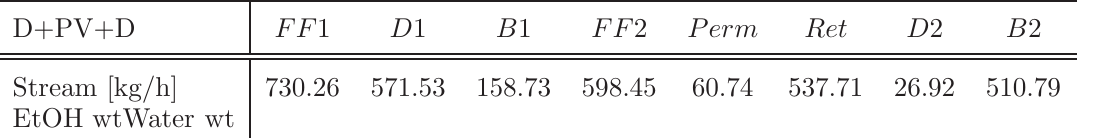
Table 7 Technological streams of adiabatic pervaporation,